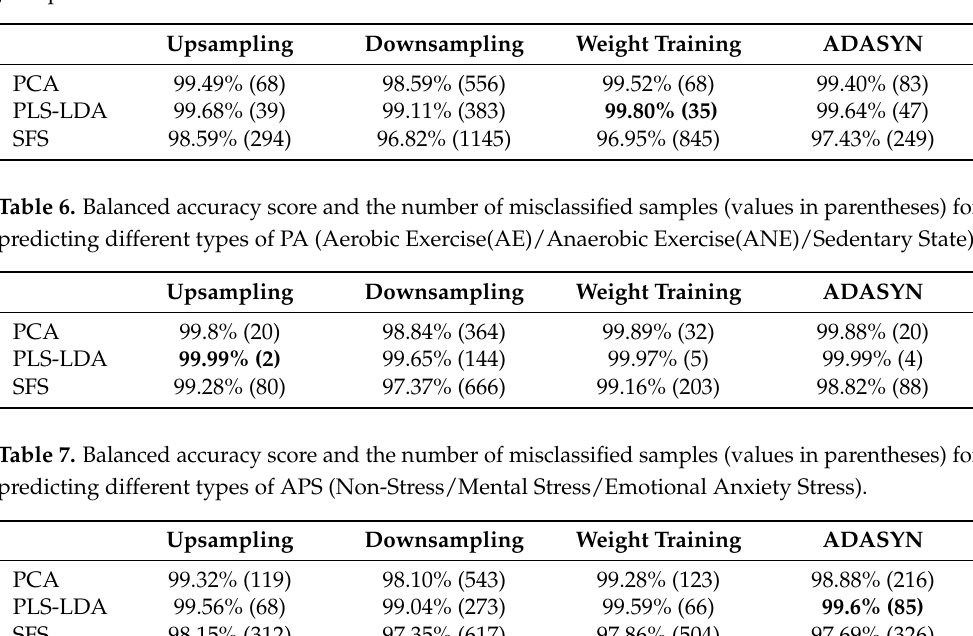
Table 5. Balanced accuracy score and the number of misclassified samples (values in parentheses) for joint prediction of PA and APS.